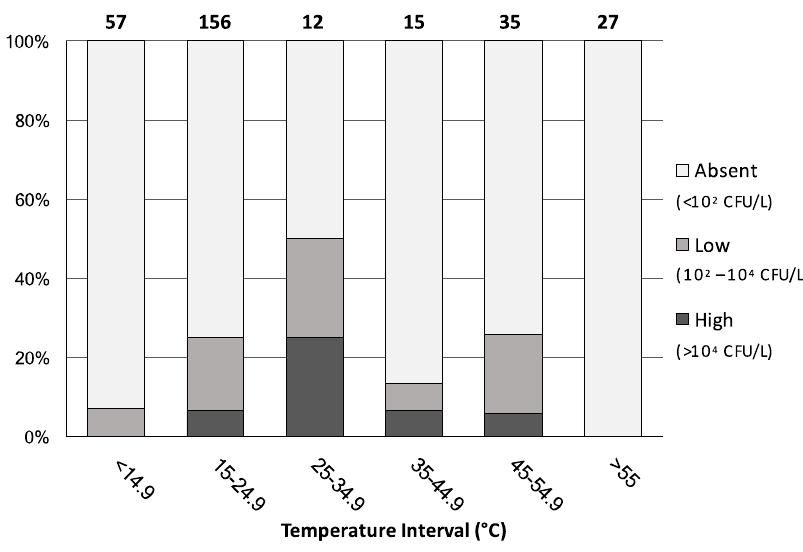
Figure 3. Percentage distribution of the analysed water samples ( n = 302) by level of contamination severity and by water-temperature intervals. Numbers above bars indicate the number of samples in each interval.